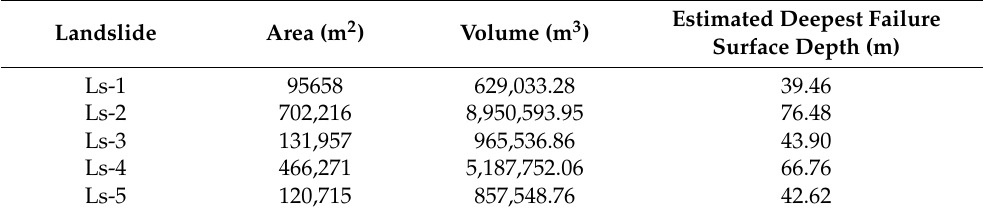
estimated empirically.